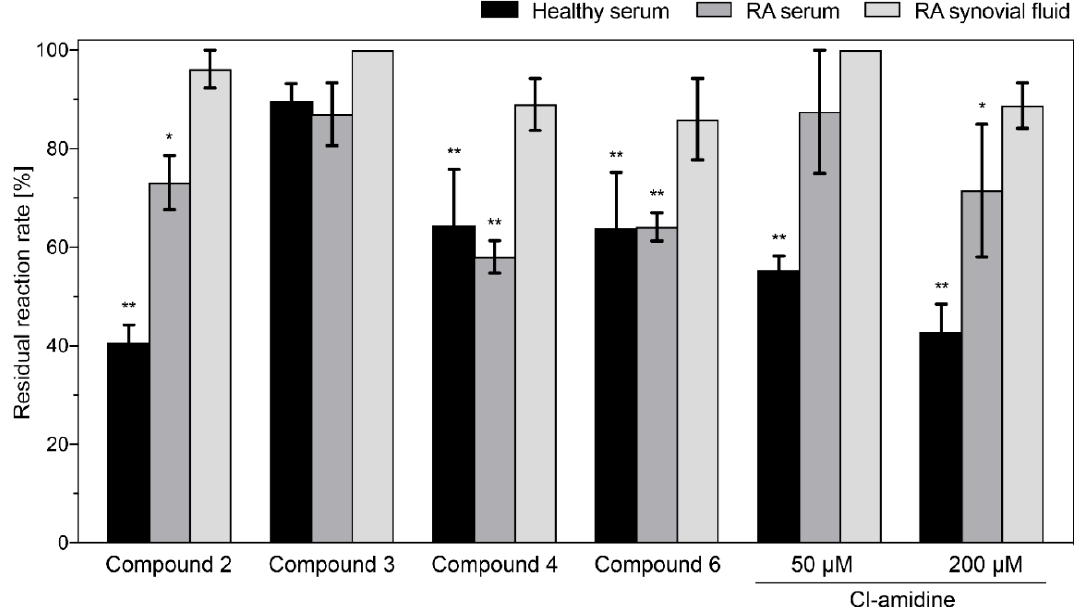
Figure 3. Residual activity of GST-PAD4 after inhibition by candidate compounds and Cl-amidine in the presence of serum from healthy blood donors, serum or synovial fluid from patients with RA. GST-PAD4 was pre-incubated with DMSO alone, 50 µ M of candidate compounds or 50 µ M and 200 µ M of Cl-amidine in the presence of 10 mM CaCl 2 , 0.5 mM DTT and 1:3 diluted serum or synovial fluid for 30 min prior to the addition of 1 mM Dansyl-Gly-Arg to initiate the enzyme assay. Product generation was evaluated by HPLC. Residual activity was determined in comparison to the respective GST-PAD4 control preincubated with DMSO alone. Black bars represent healthy serum, mid gray RA serum and light grey RA synovial fluid, respectively. Results are expressed as mean ± SD, with n ≥ 3, and the di ff erences were considered significant if (*) p < 0.05 or (**) p ≤ 0.01.